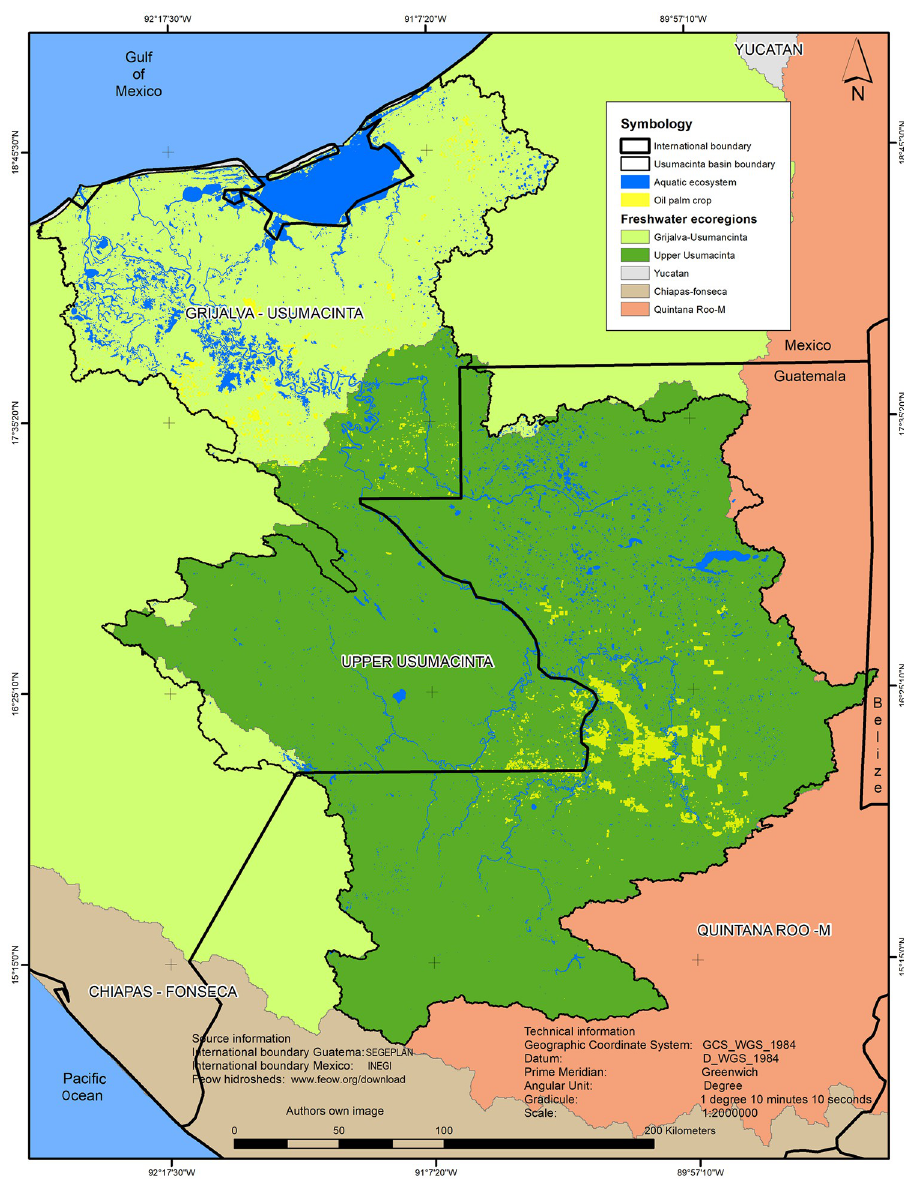
Fig 4. Spatial distribution of oil palm crops by freshwater ecoregion (2017). Note: For a better representation, in this map we include the polygons of the aquatic system used in the LULC analysis as well as the drainage network (lines). (Data source: Shape file of the freshwater ecoregions of the world courtesy of Freshwater ecoregions of the world (FEOW).